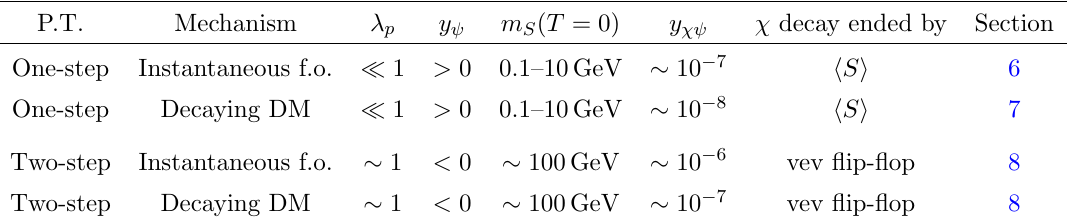
Table 2 . A summary of the mechanisms that operate in various regions of parameter space. In the (cid:12)rst column we give the nature of the phase transition of the new scalar S . In the penultimate column we note whether the (cid:31) decay and inverse-decay channel closes due to the vev of S